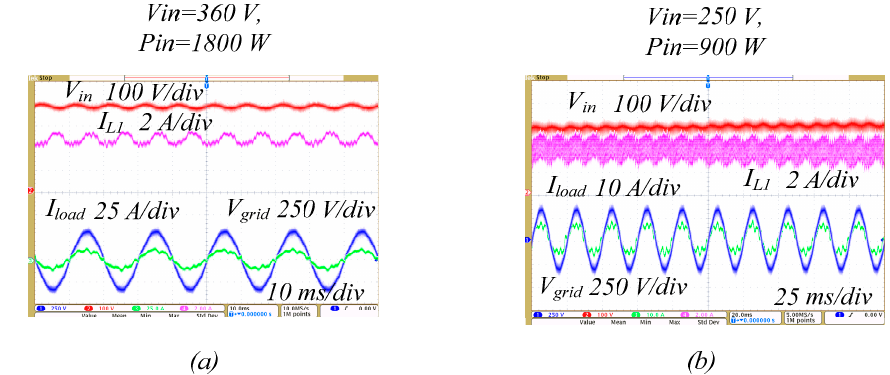
Figure 8. Grid-connected operation of 3L NPC QZSI at a nominal power level of 1800 W ( a ) and in boost voltage mode at a reduced power level of 900 W ( b ).